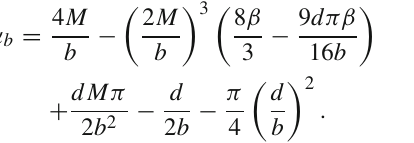
Fig. 16 α b fordifferentvalue a , b , r c and β inthenon-singularisother- mal sphere uniform plasma, λ = 1 case